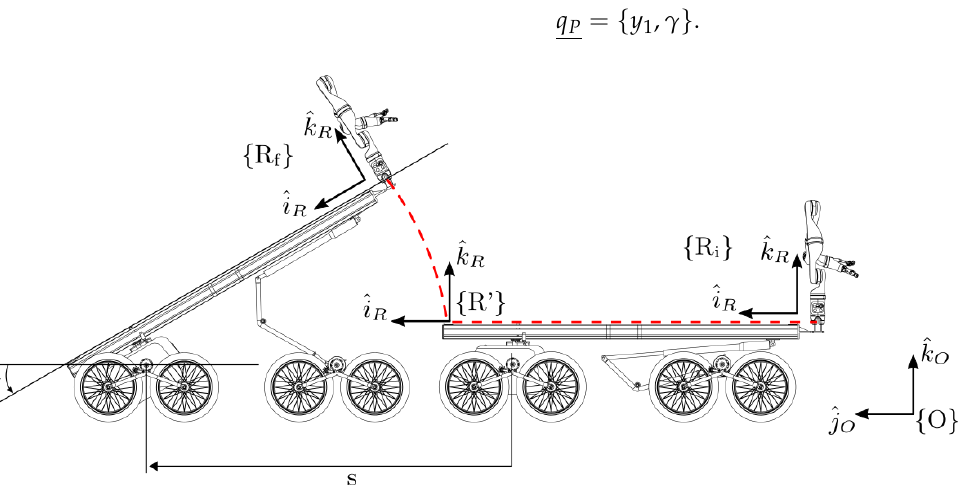
Figure 7. Effect of s and γ on the position and orientation of the manipulator. { R i } is the initial configuration of the manipulator, { R (cid:48) } takes into account the effect of the linear motion s along ˆ j O , and { R f } is the final configuration of the manipulator, also with the contribution of the pitch angle γ